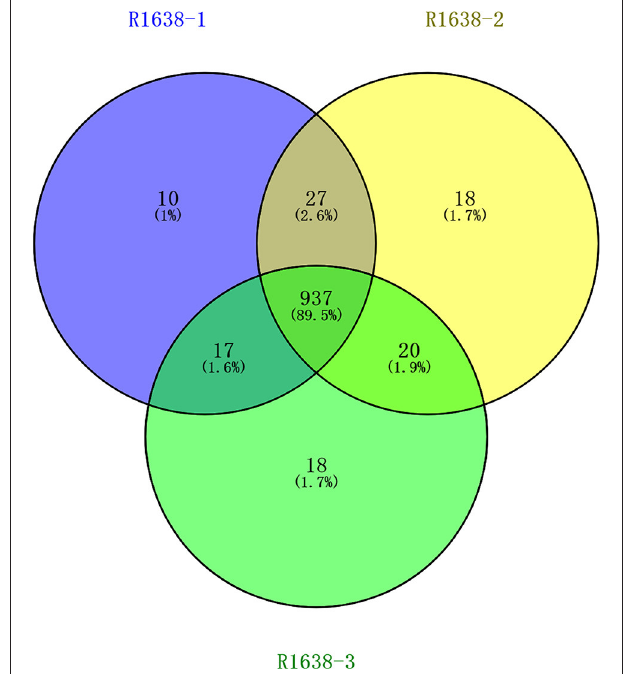
FIGURE 1 | Venn diagram for serum protein identification. After preparation, the samples were lyophilized and incubated at 37 ◦ C for 16–18h with 40 µ l trypsin buffer. The hydrolysates were separated using capillary high-performance liquid chromatography and analyzed using Thermo Fisher mass spectrometry. MaxQuant 1.5.5.1 Searched the corresponding database, and finally obtained the results of protein identification and quantitative